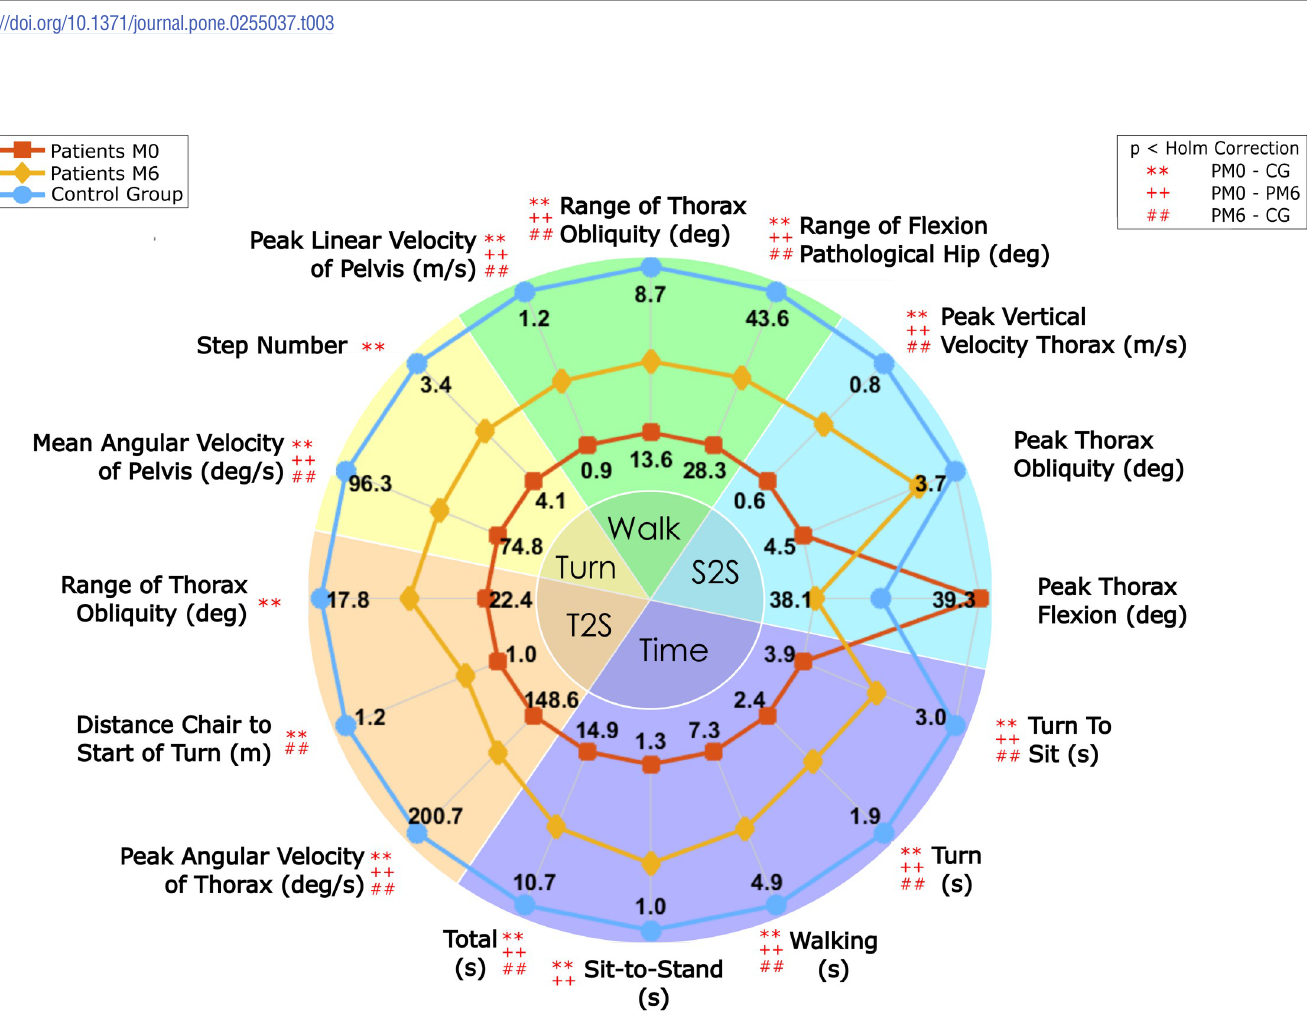
Fig 2. Overview of each phase’s duration and the features selected using PCA for all three groups: Patients before surgery (PM0), patients six months after surgery (PM6) and Control Group (CG). Feature values representing higher levels of function are on the outer edge, and lower levels of function are on the inner edge. S2S = Sit-to-Stand; T2S = turn-to-sit.